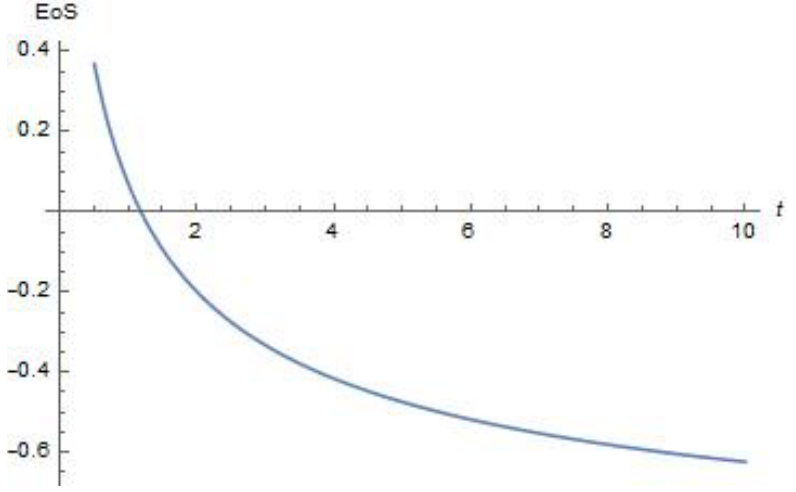
Figure 6. EOS parameter ω against time t (in Gyr